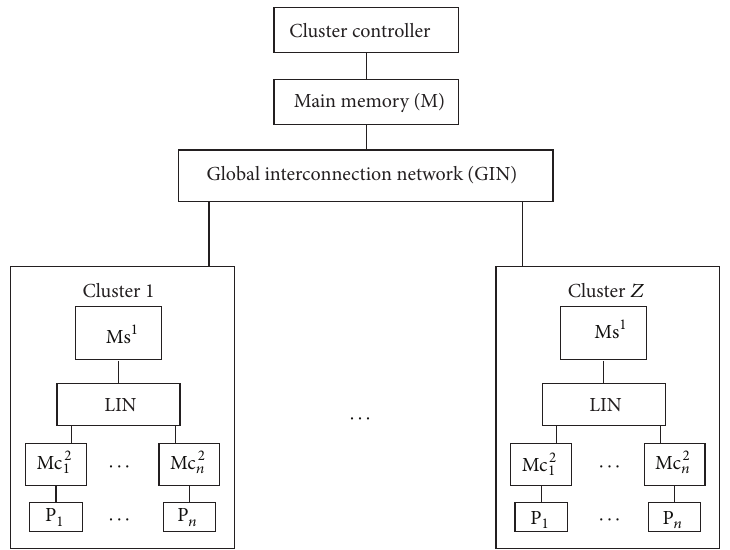
Figure 2: Hierarchical shared memory cluster architecture